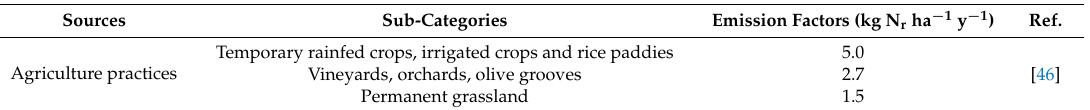
Table 2. Nitrogen export coefficients, according to agriculture